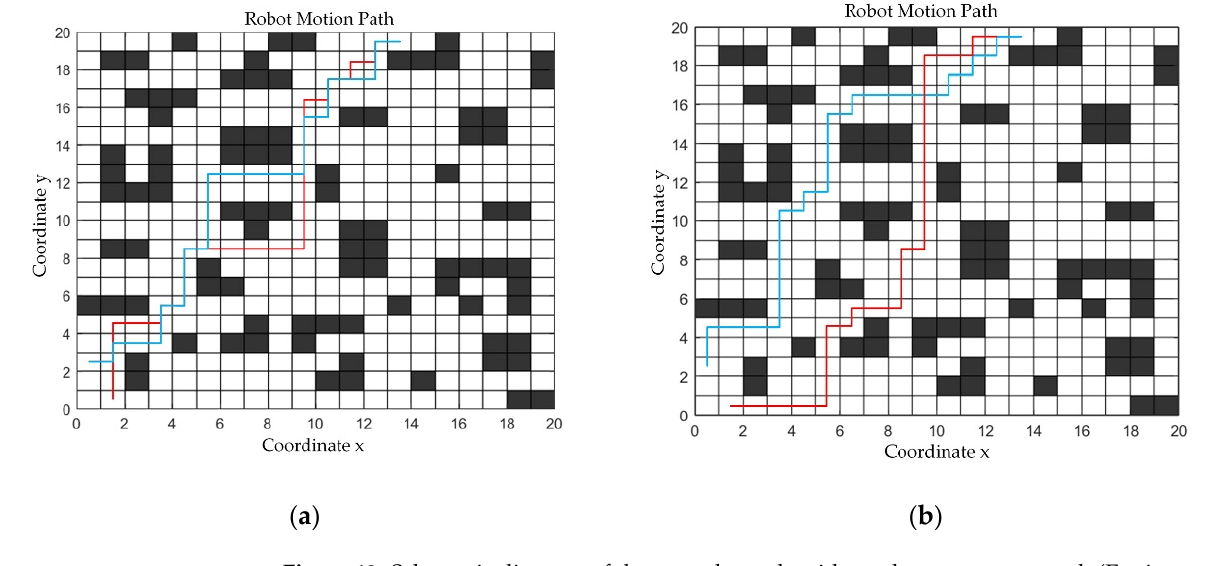
Figure 13. Schematic diagram of the ant colony algorithm robot movement path (Environment 2). ( a ) Ant colony algorithm ( b ) Improved ant colony algorithm.